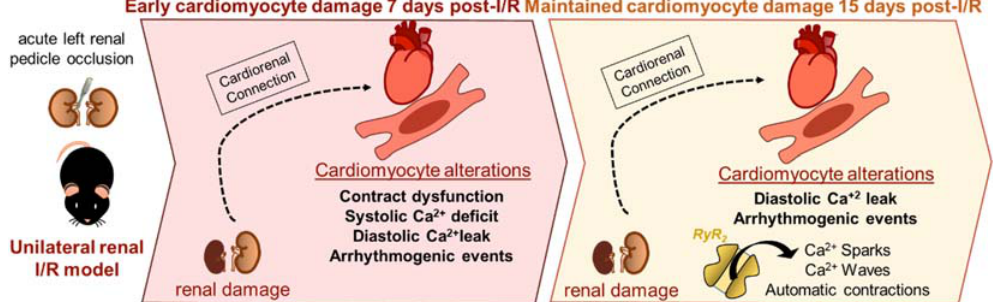
Figure 7 . Schematic drawing of the take ‐ home